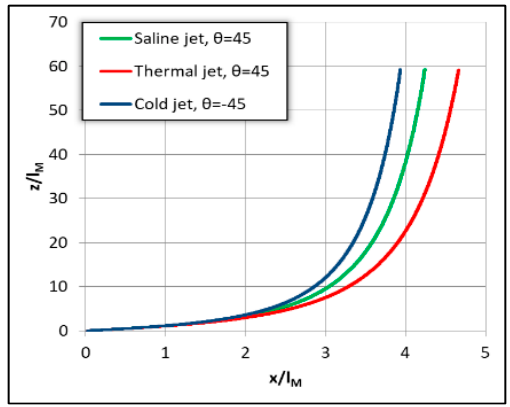
Figure 9. Normalized positively buoyant jet trajectory at θ ο = 45°.